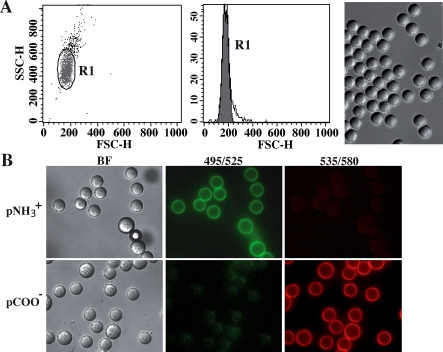
Colloidal Substrates(A) FCM scattering plot and corresponding bright field microscope images of a COO– particle sample washed in water and suspended in PBS. 80% of events were concentrated in the scattering value region R1 corresponding to a monodispersed, 10-μm-diameter population. Outliers corresponded to a population of slightly larger particles and a few doublets. Cationic (NH3
+) particles displayed the same scattering characteristics as anionic (COO–) particles.(B) Microscopic images of PYR- (2nd column) and PI- (3rd column) labeled cationic (1st row) and anionic (2nd row) particles. Dye concentration equal to 16.7 nM.